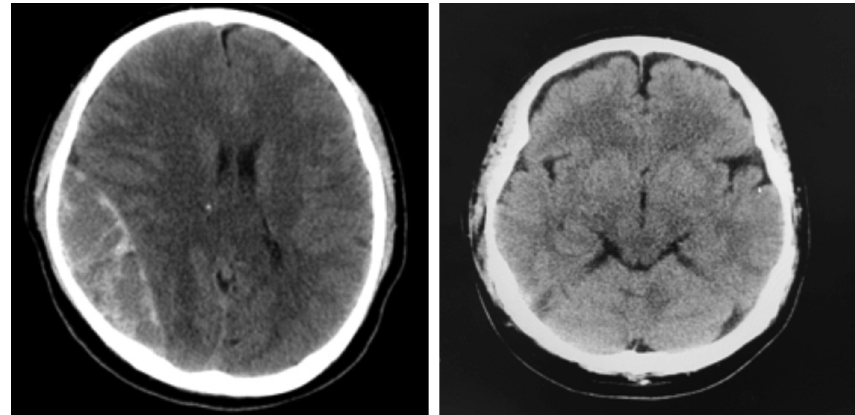
(a) MRI axial view and (b) CT sagittal view showing location Fig. 1: of arachnoid cyst in sacral canal in close proximity with left S1 nerve root.